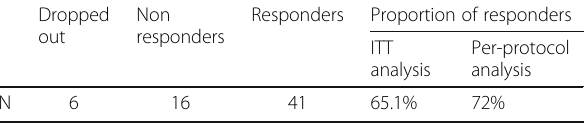
Table 1 Primary outcome measure